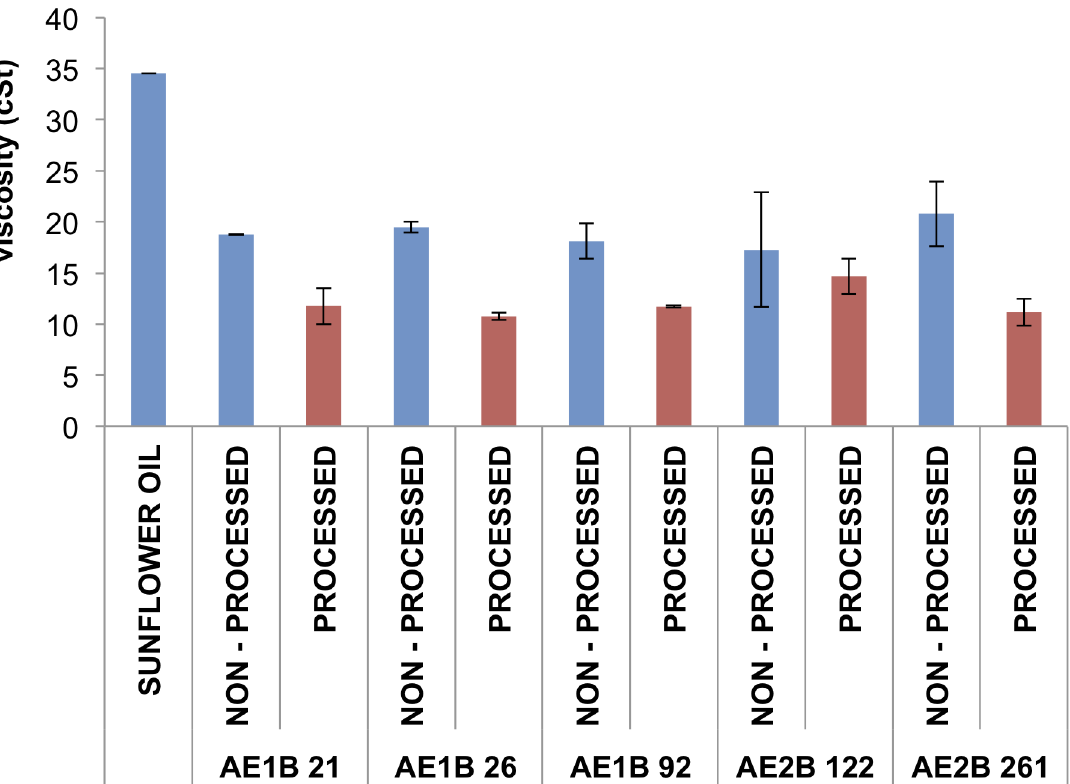
Figure 4. Viscosity of the sunflower oil, and the transesterification product using processed and non-processed supernatants of selected bacteria. Biofuel (FAEE + MG) was obtained by transesterification reaction of sunflower oil and ethanol with processed or non-processed supernatants of the best 5 biofuel-producing bacterial strains. Data are the average of at least two independent experiments.